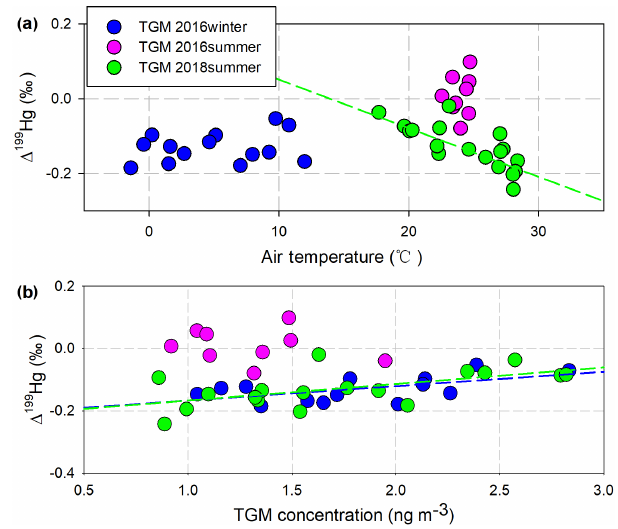
Figure 3. The correlation between (cid:49) 199 Hg in the TGM and air temperatures (a) and between (cid:49) 199 Hg in the TGM and TGM con- centrations (b) . Regressions lines were colored to match the TGM scatter plots.